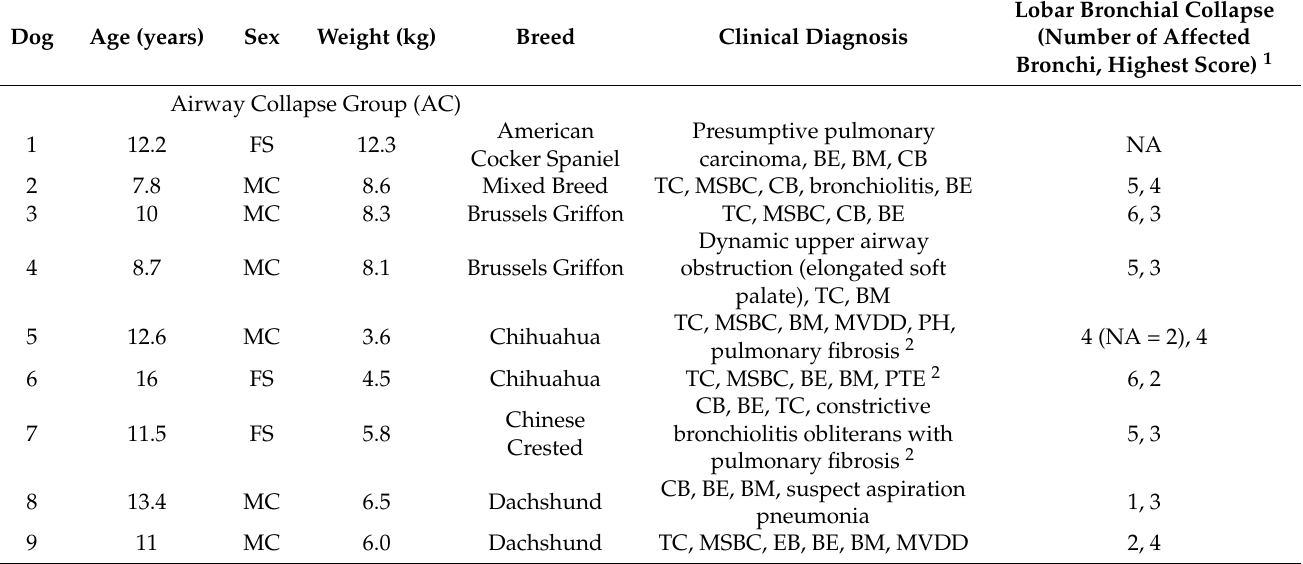
Table 2. Study population demographics and clinical diagnoses according to group including dogs with airway collapse (AC), dogs with non-collapsible airway disease (NCAD) and dogs with other non-lower airway respiratory diseases